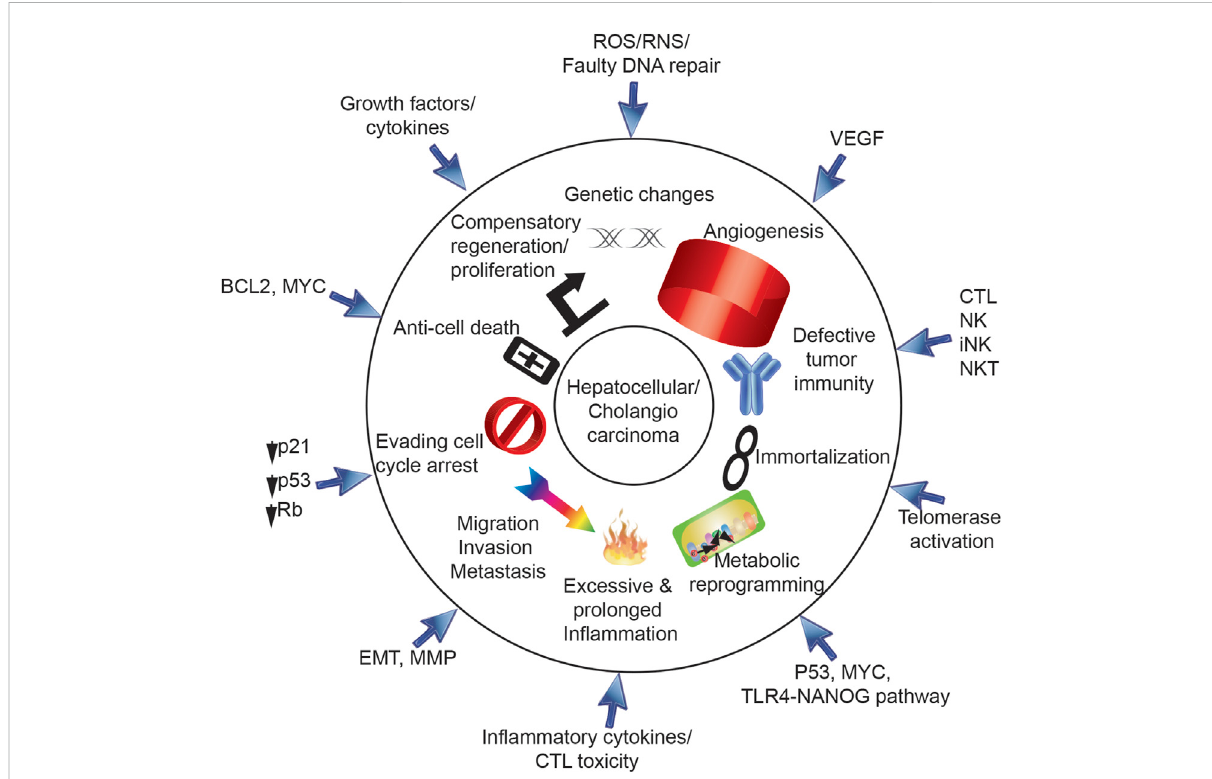
FIGURE 1 Ten hallmarks for cancerdevelopment viaHCV. Ten hallmarks ofcancer aretriggered byHCV, including 1)geneticchanges, 2)angiogenesis,3) defective tumor immunity, 4) immortalization, 5) metabolic reprogramming, 6) excessive and prolonged in fl ammation, 7) migration/invasion/ metastasis, 8)evading cellcyclearrest,9) anti-cell deathand 10)compensatoryregeneration/proliferation.HCV core protein,E1,E2,NS3, NS5A,and NS5B are involved in progression of HCV-induced